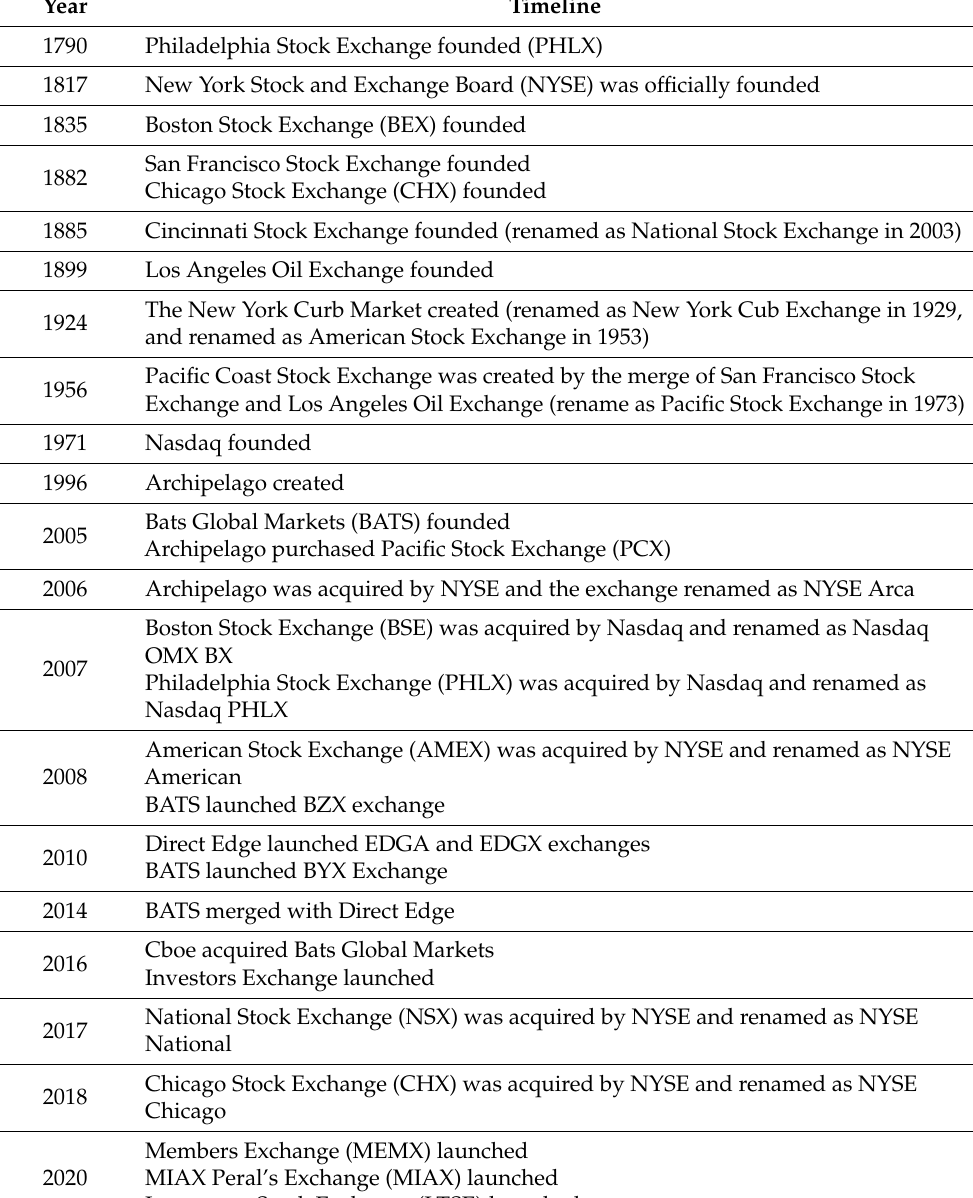
Table 1. Timeline of the evolution for U.S. equity national